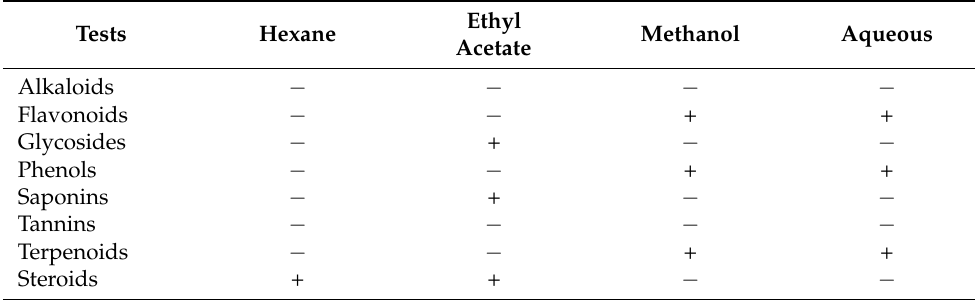
Table 1. Phytochemical analysis of different solvent extracts of F. arabica